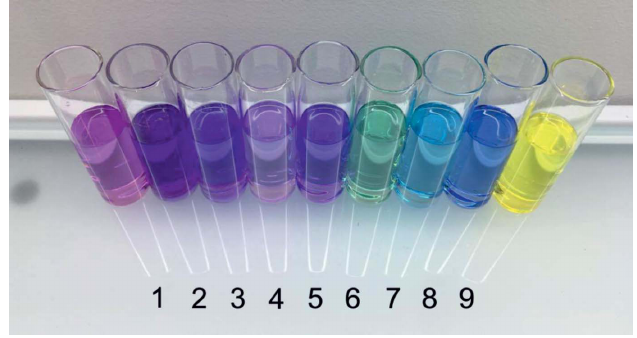
Figure 3 Solutions of tyraminium violurates in (1) water, (2) methanol, (3) ethanol,